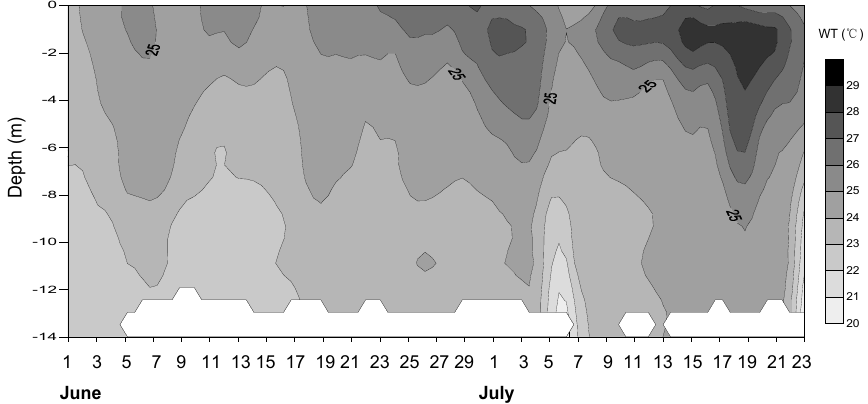
Figure 3. Isolines of the daily average water temperature (WT) profile of Xiangxi Bay from 1 June to 23 July, 2008. The white area is the bottom of the bay.